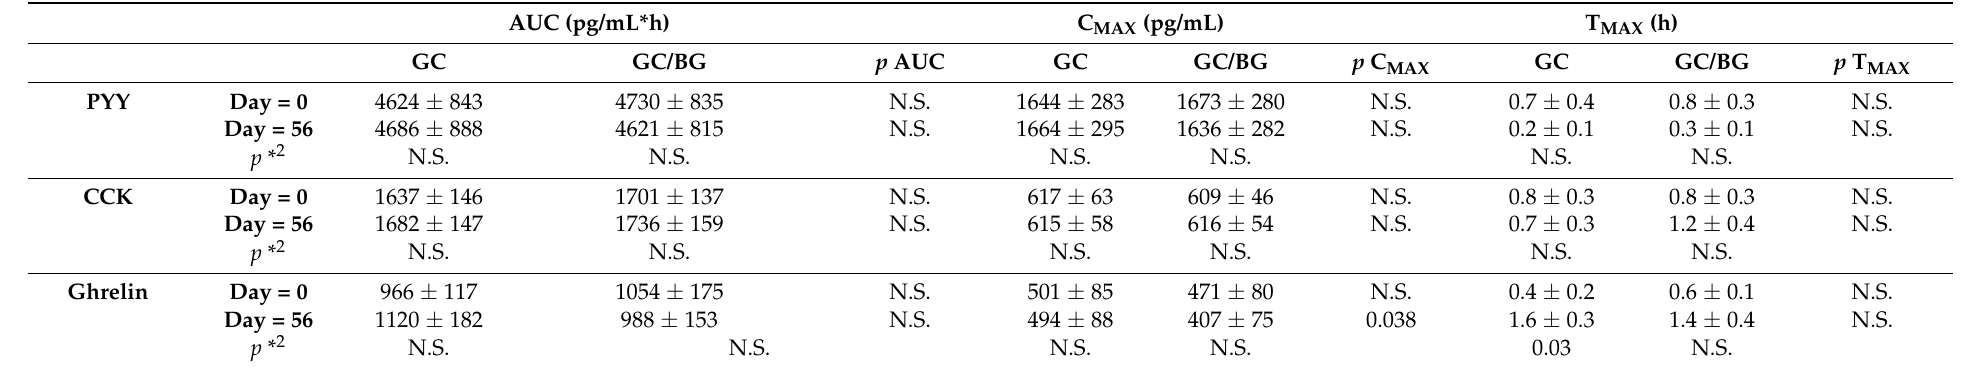
Table 4. Effects of the consumption of GC or GC/BG extracts in the area under the curve 30–120 min (AUC 30–120 ), maximum concentration (C MAX ) and time to maximum concentration (T MAX ) for the satiety-related hormones